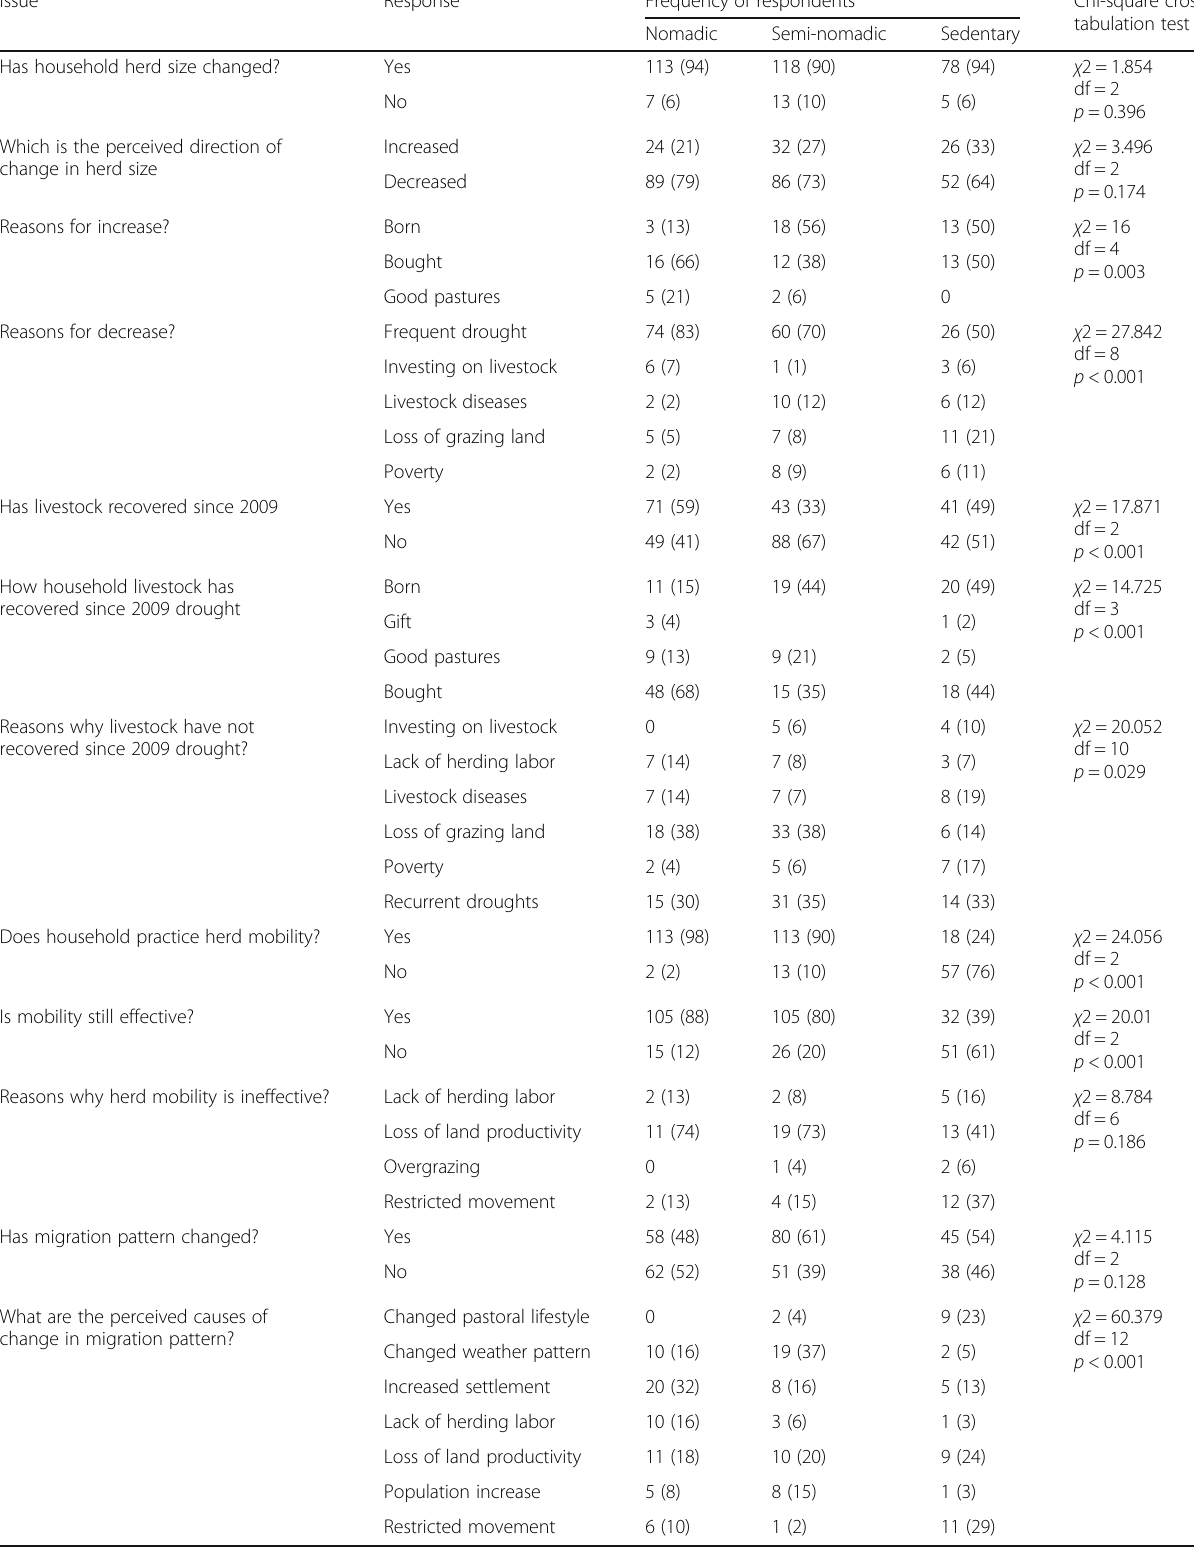
Table 2 Views on herd size dynamics and management practices over the last four decades as perceived by the